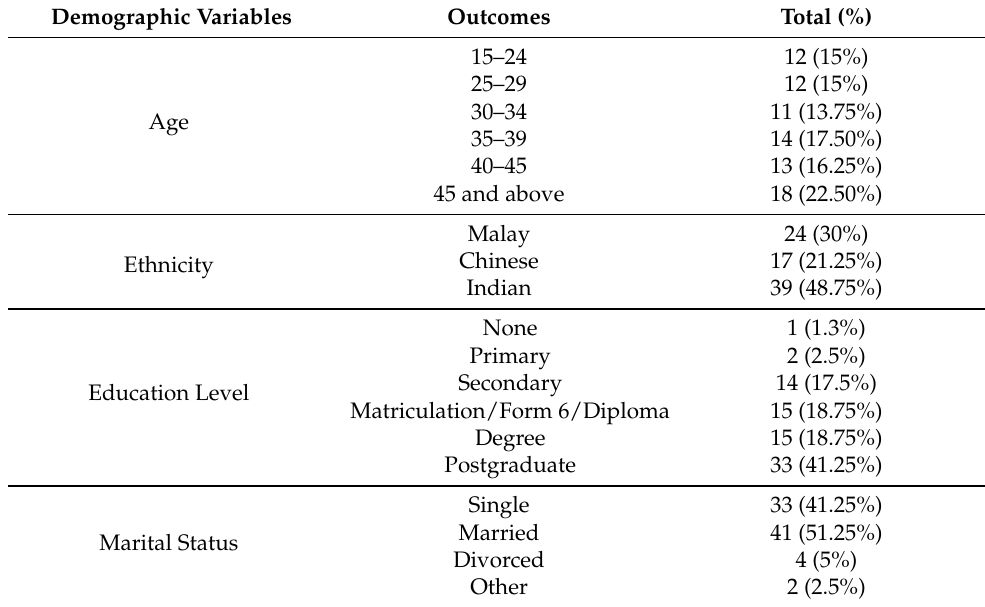
Table 1. Demographics of the Study